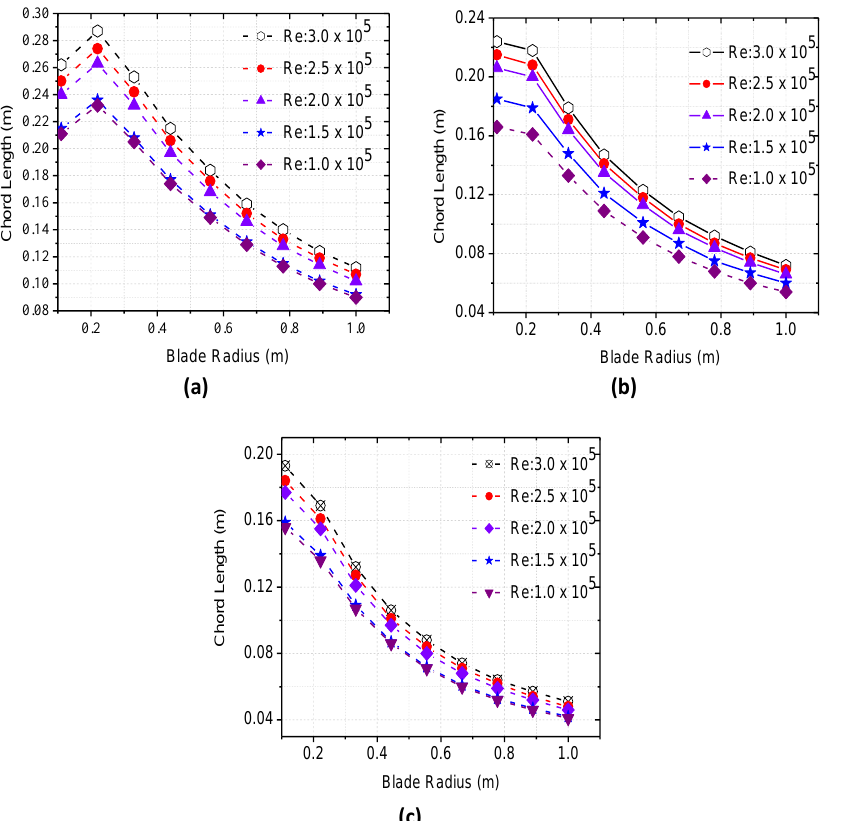
Figure 5. Blade optimum chords distribution for NACA 4412 airfoil at ( a ) TSR 4; ( b ) TSR 5; ( c ) TSR 6.